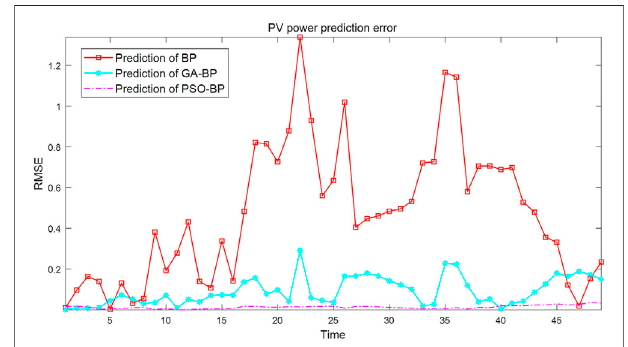
FIGURE 6 | MAPE of three PV power prediction models.